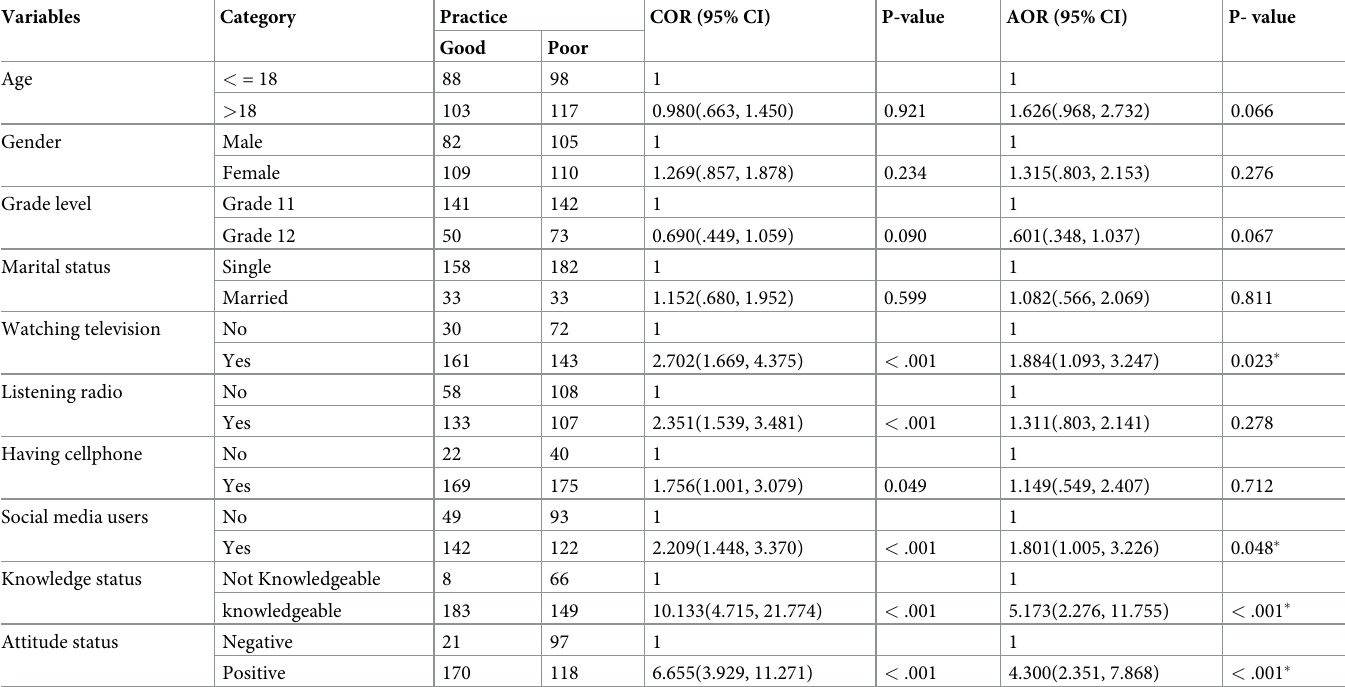
Table 5. Factors associated with COVID-19 prevention practice among preparatory school students at Mizan-Aman town, 2021 (n =